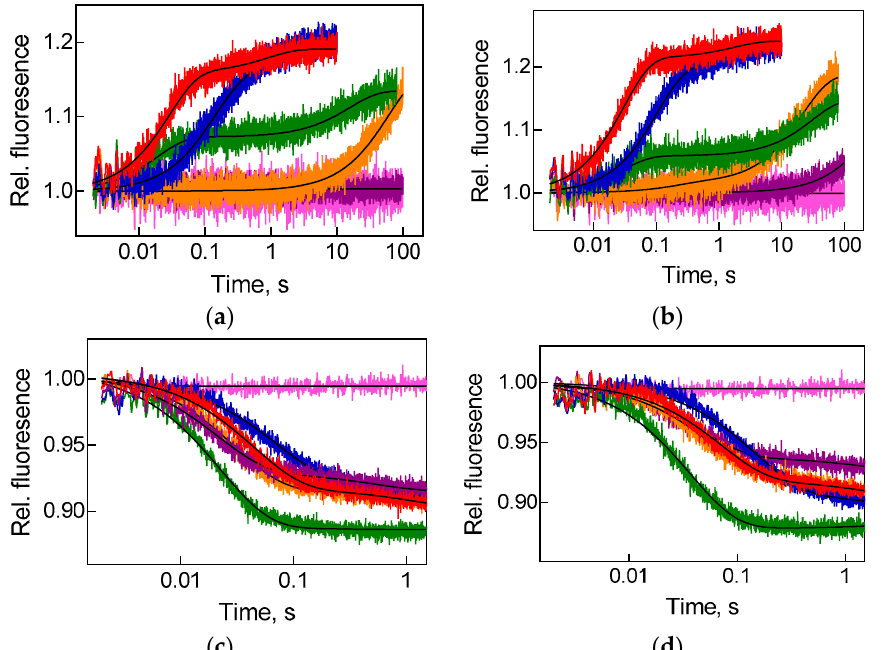
Figure 6. Inhibition of translocation by antibiotics. Time courses of translocation upon rapid mixing of pretranslocation ribosomal complex (0.06 µM) containing deacylated tRNA Met in the P site and fMet-Phe-tRNA Phe in the A site with EF-G (5 µM) from ( a,c ) E. coli or ( b , d ) T. thermophilus . ( a , b ) Fluorescence intensity change upon movement of fMet-Phe-tRNA Phe (Prf16/17) labelled at the elbow region of tRNA. ( c , d ) Fluorescence intensity change upon movement of BPY-Met-Phe-tRNA Phe labelled at CCA-end of tRNA. Colour code: reaction without antibiotic (red trace), with streptomycin (dark blue trace), viomycin (violet trace), hygromycin B (orange trace), spectinomycin (green trace) or upon addition of buffer TAKM 7 instead of EF-G (pink trace). Single- or double-exponential fits are black lines, numerical values are provided in Table 2. Each time course reflects the average of 5 to 7 technical replicates. S.e.m. associated with the kinetics were calculated by the GraphPad Prism software. Table 2. Influence of antibiotics on tRNA translocation.